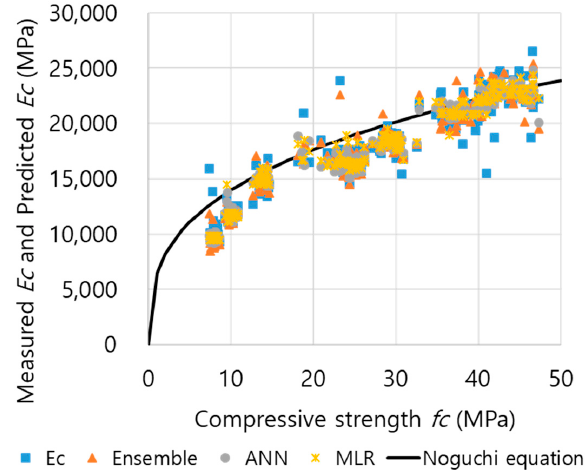
Figure 16. Relationship between Ec (measured Ec and predicted Ec ) and fc .